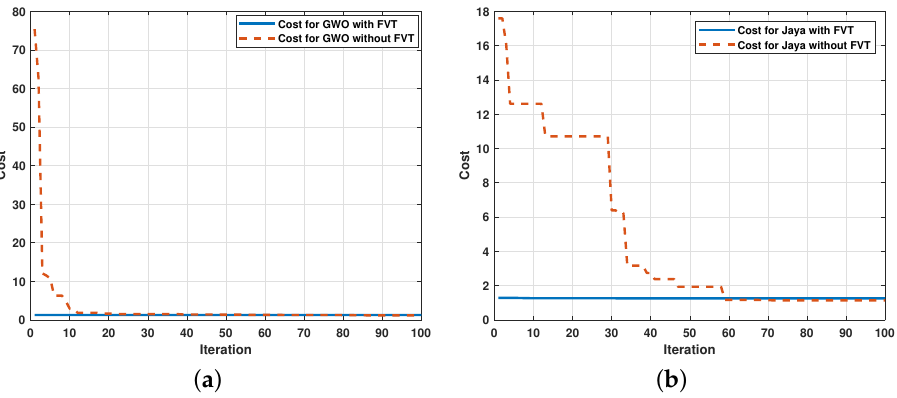
Figure 14. Convergence speed of metaheuristic algorithms for the real electromechanical system: ( a ) Comparison of the performance of the Jaya using the FTV in the real electromechanical system; ( b ) Comparison of the performance of the GWO without the FTV in the real electromechanical